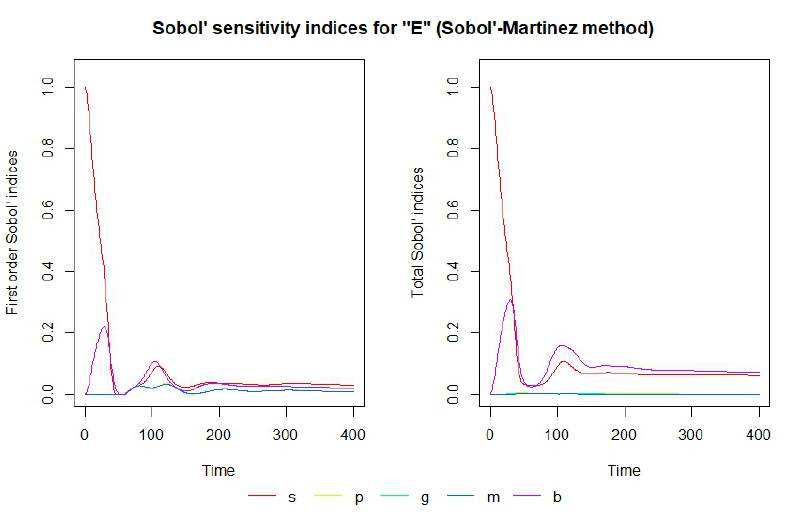
Fig. 2. Sensitivity Analysis: Effector Cells